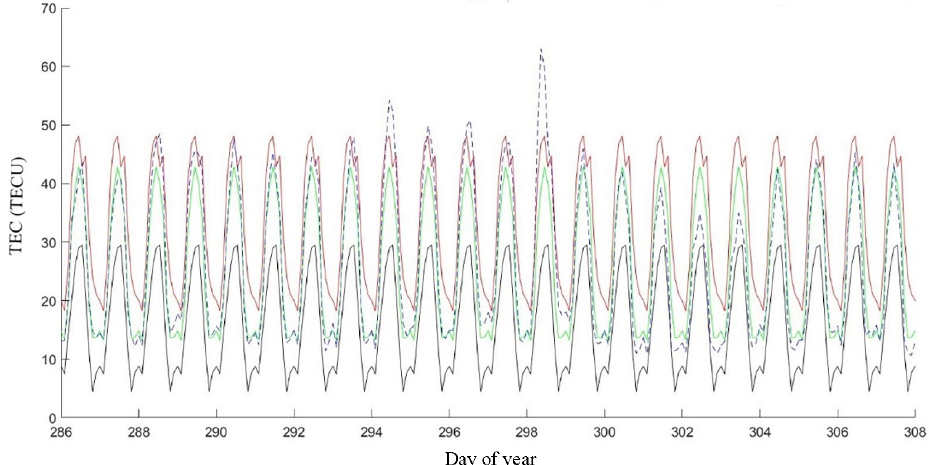
Figure 3. GIM-TEC values for OZAL Station. The black line shows lower bound TEC values, the red line demonstrates upper bound TEC values, the green line shows mean TEC values and the dotted line indicates observed TEC values for every epoch.